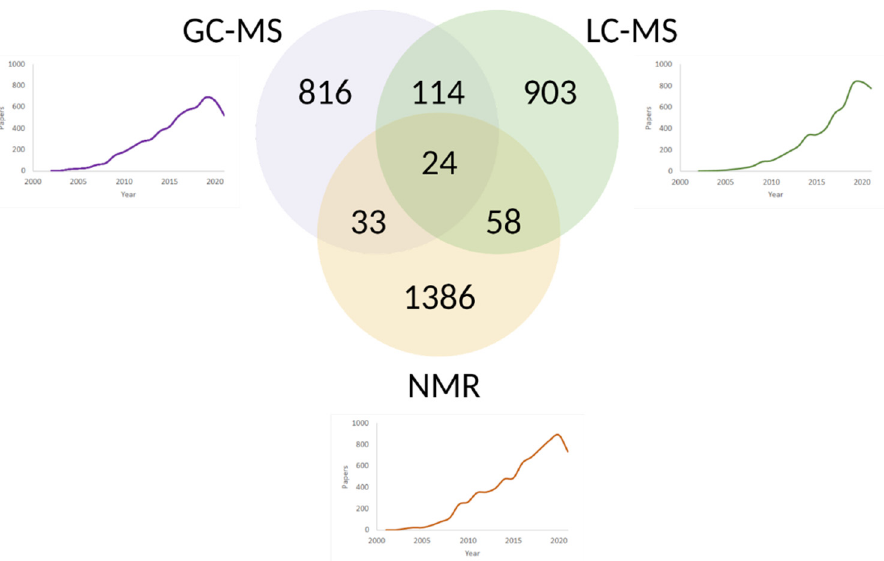
Figure 2. Venn diagram and timelines comprising the number of scientific publications on blood metabolome studies via LC-MS, GC-MS, and NMR up to date. The queries “LC-MS blood metabolome”, “GC-MS blood metabolome” and “NMR blood metabolome” were addressed to the PubMed repository. The leader in the number of publications is the most mature NMR technology, followed by gas and liquid chromatography in tandem with MS. Due to the different applicability of NMR, LC-MS, GC-MS for various classes of metabolites, the combination of two or even three analytical platforms has been used in 200+ metabolomics projects. The synergy is especially noticeable between GC-MS and LC-MS, used together approximately in 7% of mass spectrometry ‐ based experiments.